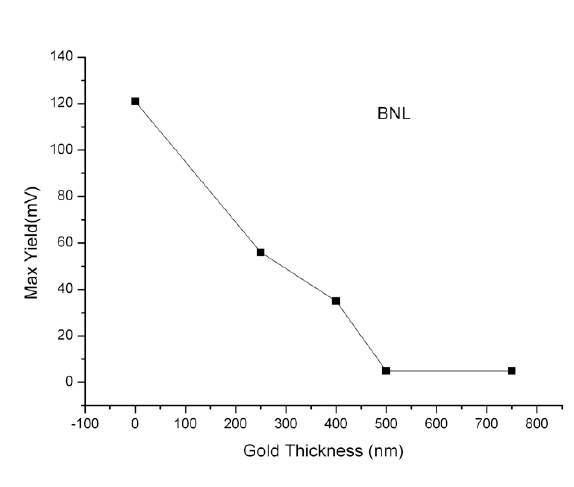
Fig. 2. ToF spectra for coated target irradiated at BNL, the reduction of energy and yield follow the thicknesses of gold films.